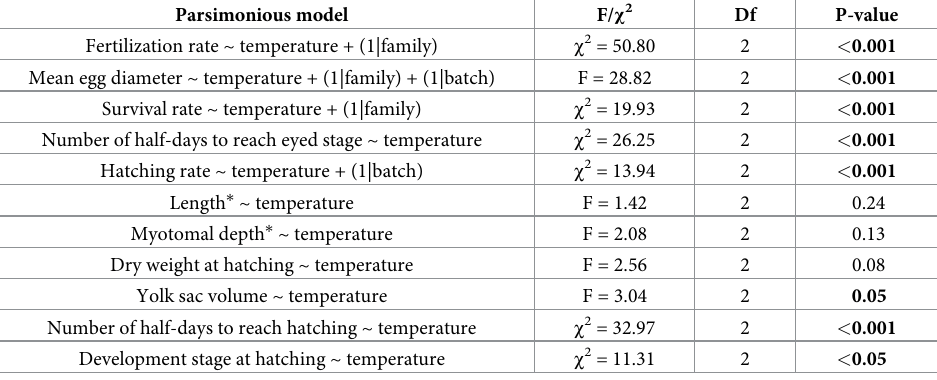
Table 2. Impact of temperature on fertilization rate and embryonic traits of Downs herring ( Clupea harengus ). P-values in bold are statistically significant (statistical significance was assigned at α = 0.05). F: ANOVA F-test; χ 2 : Wald test; * indicates traits that were log